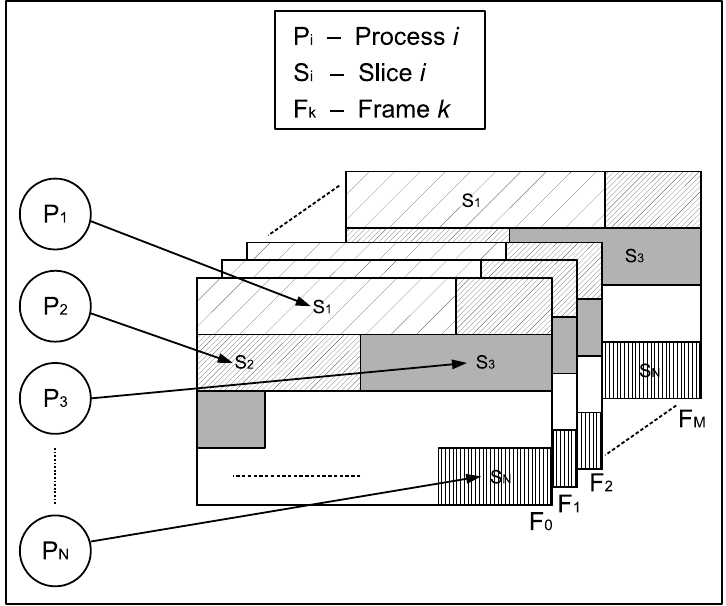
Figure 2. Slice-based parallel